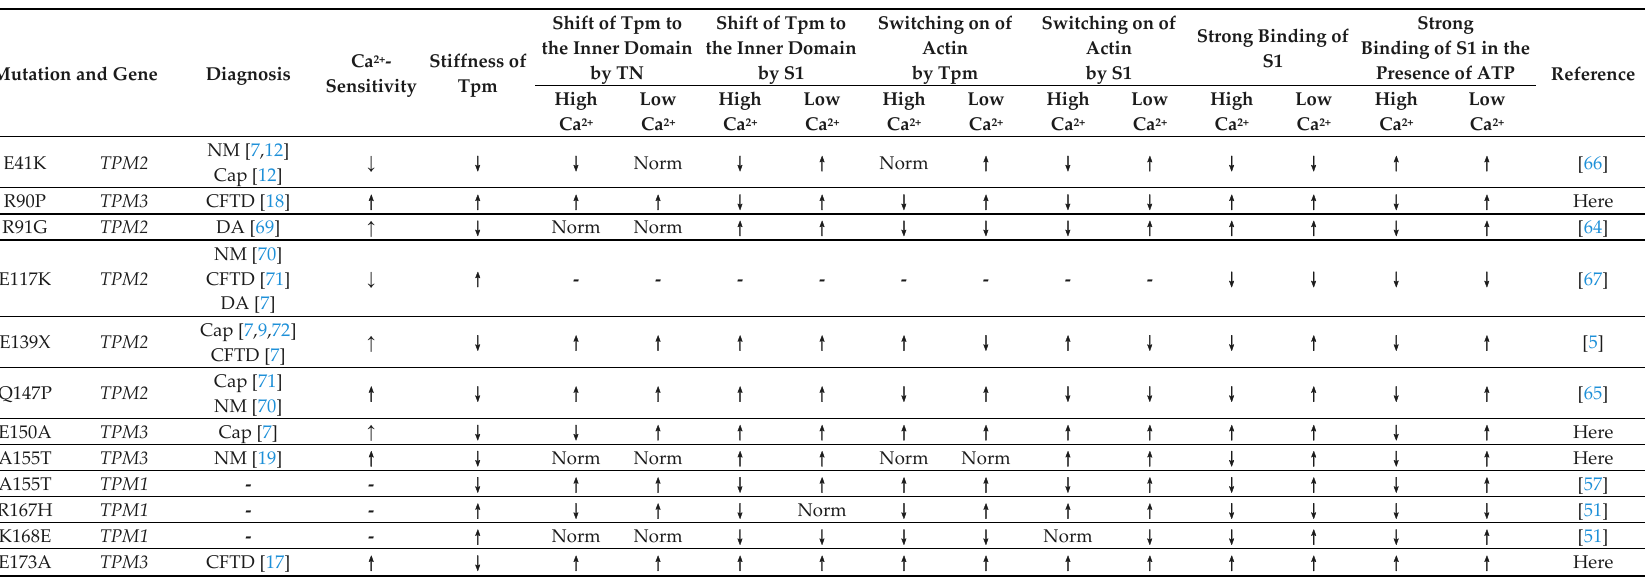
Table 1. The effect of the point mutations in Tpm on behavior of Tpm, actin and myosin during the ATPase cycle.